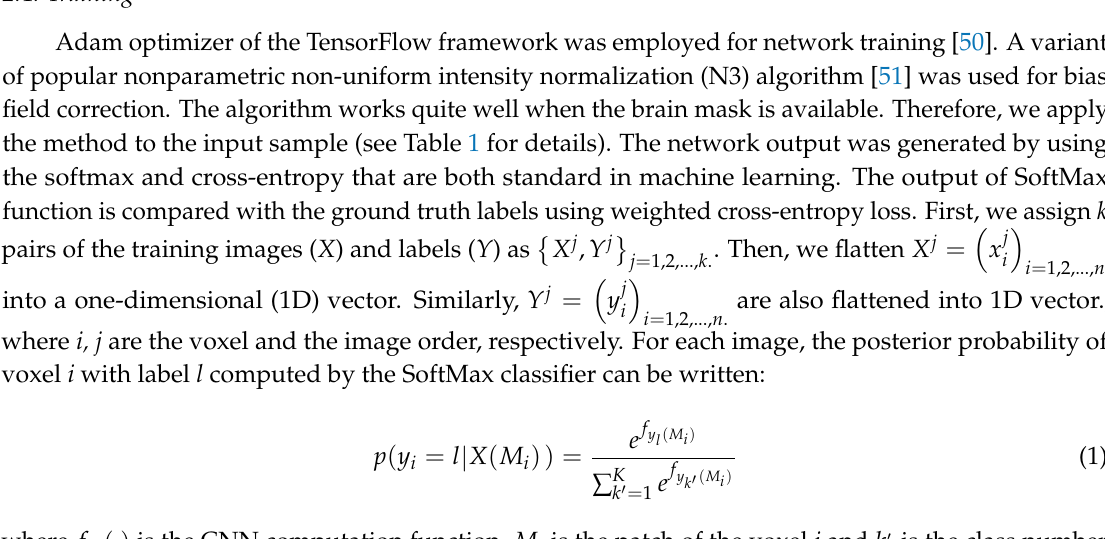
Figure 1. 3D U-Net architecture. Blue blocks are output from convolutional neural network (CNN), batch normalization (BN), and ReLu. Green arrows are concatenation with cropped feature map from encoder part. The number above each blue box is the number of channels. The transparent box with blue outlines (except the input/output) on the decoder is the concatenated box from the encoder.